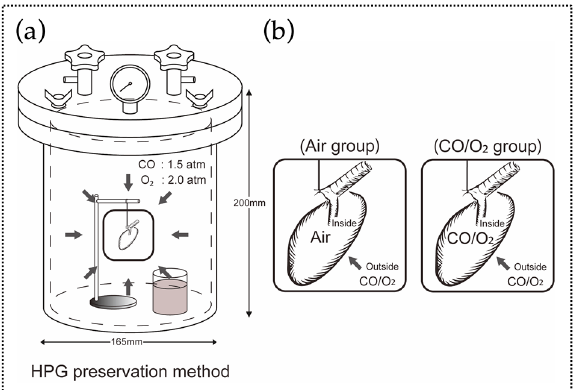
Figure 1. Schematic representation of the preservation method (Experiment 1). ( a ) Donor lungs were preserved in a chamber with high-pressure carbon monoxide (CO; 1.5 atm) and oxygen (O 2 ; 2.0 atm). ( b ) Before preservation, donor lungs were filled with either room air (containing nitrogen (N 2 ) and O 2 at a ratio of 4:1; air group) or a mixture of CO and O 2 at the same ratio as that outside (CO:O 2 , 3:4; CO/O 2 group).